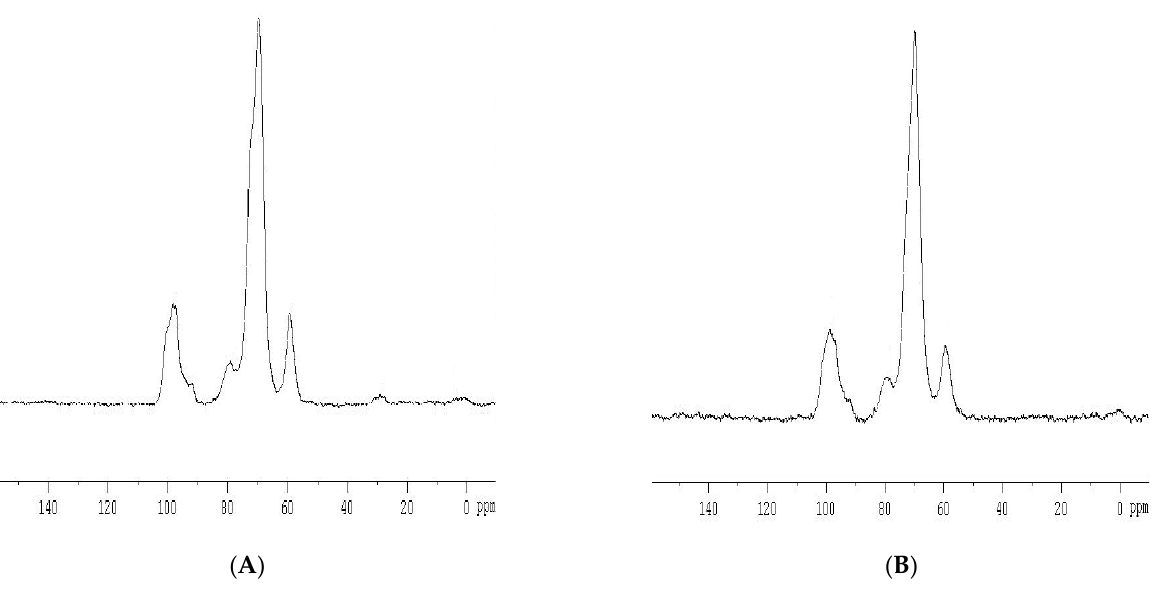
Figure 2. 13 C-NMR Spectra of ( A ) sago starch ( δ : 98.0, 78.9, 69.7 and 59.2 ppm); ( B ) pregelatinised sago starch ( δ : 98.6, 79.1, 69.7 and 59.4 ppm).